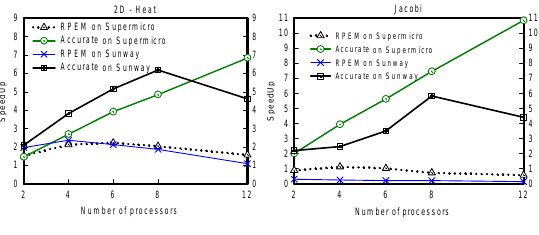
Supermicro server and Sunway cluster. The detailed code of 2D-Heat can refer to Ref 16.